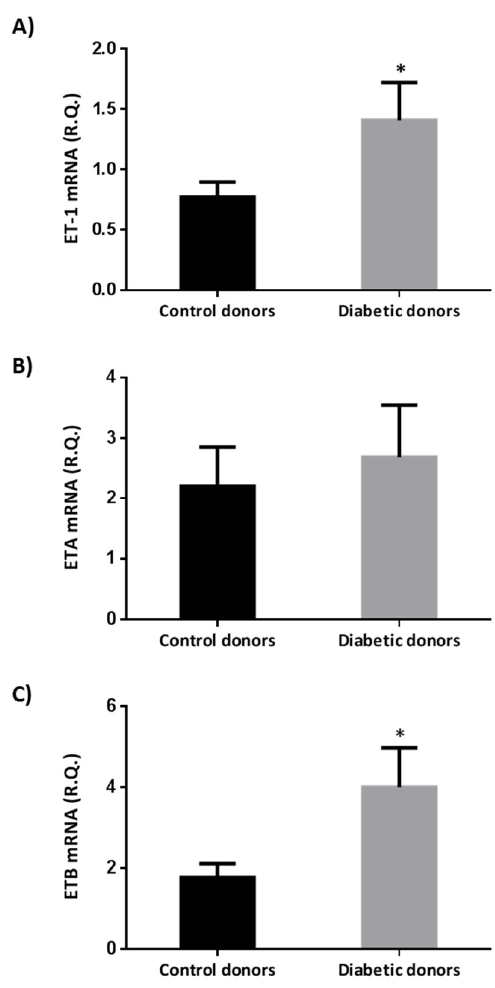
Figure 1. Real-time quantitative RT-PCR analysis of Endothelin-1 (ET-1) mRNA ( A ) endothelin A-receptors (ETA) mRNA ( B ), and endothelin B-receptors (ETB) mRNA ( C ) in human retinas from diabetic and non-diabetic donors. The study was performed in 12 donors with diabetes and 12 donors without diabetes. R.Q.: Relative quantification. Data are mean ± standard error. The Student t test was used for comparisons. * p < 0.05.